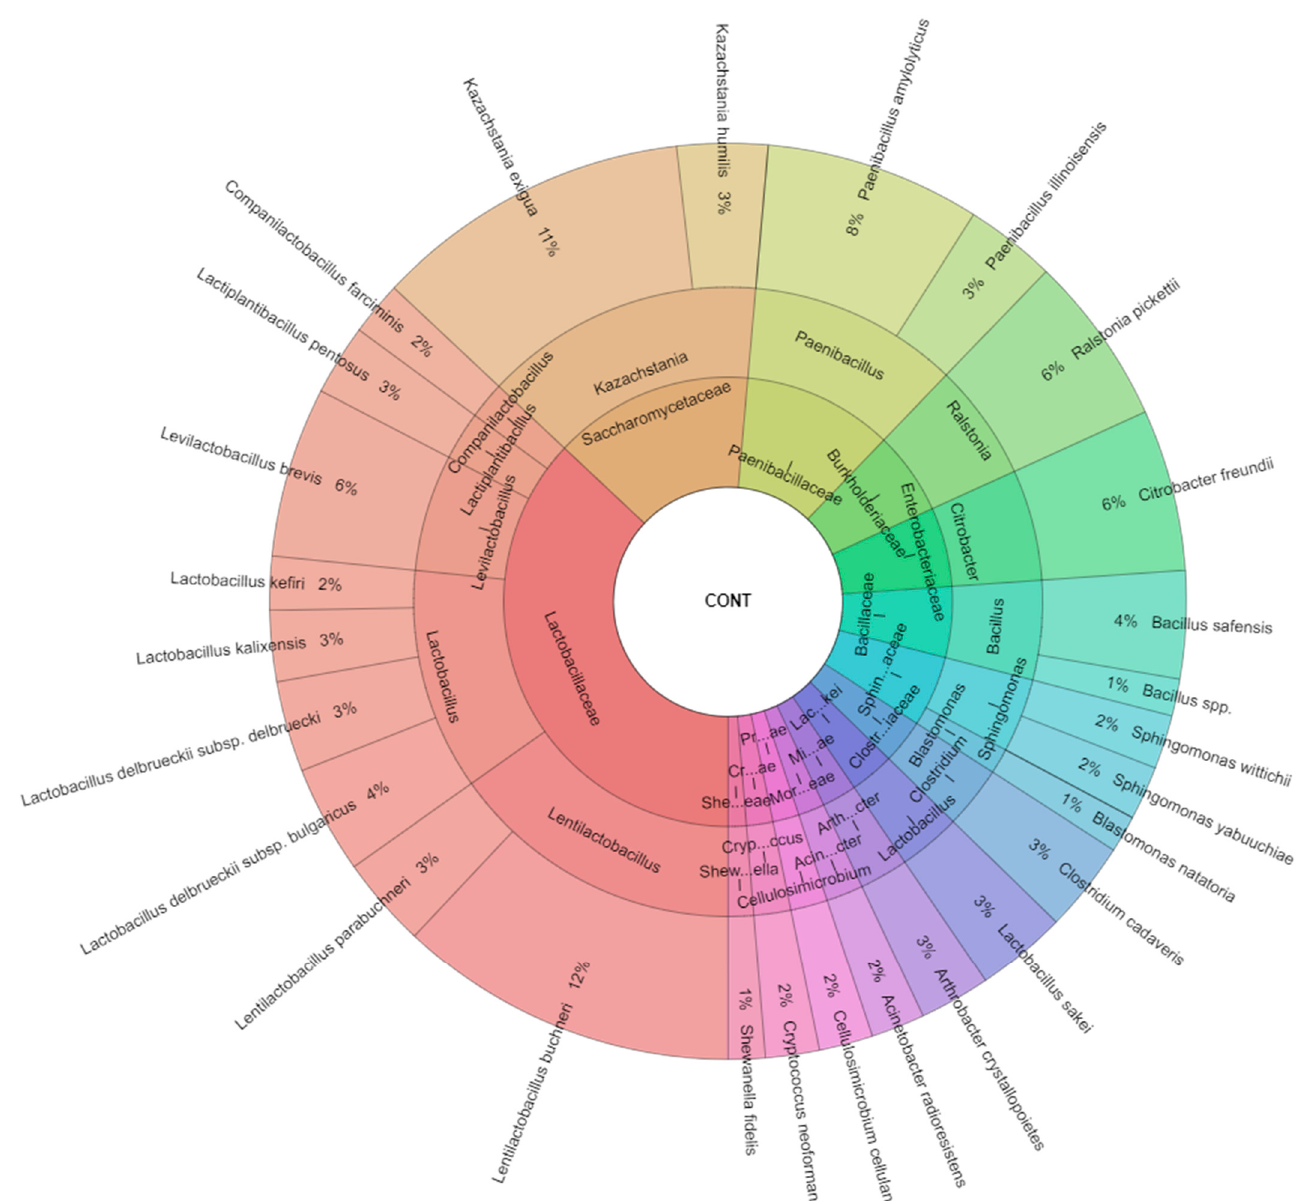
Figure 2. Krona chart of isolated species of bacteria and yeasts from control samples of corn silage. All isolated species in corn samples with the addition of LAB were 19 species and the most isolated species were from the families Lactibacillaceae (5 species) and Bacil-